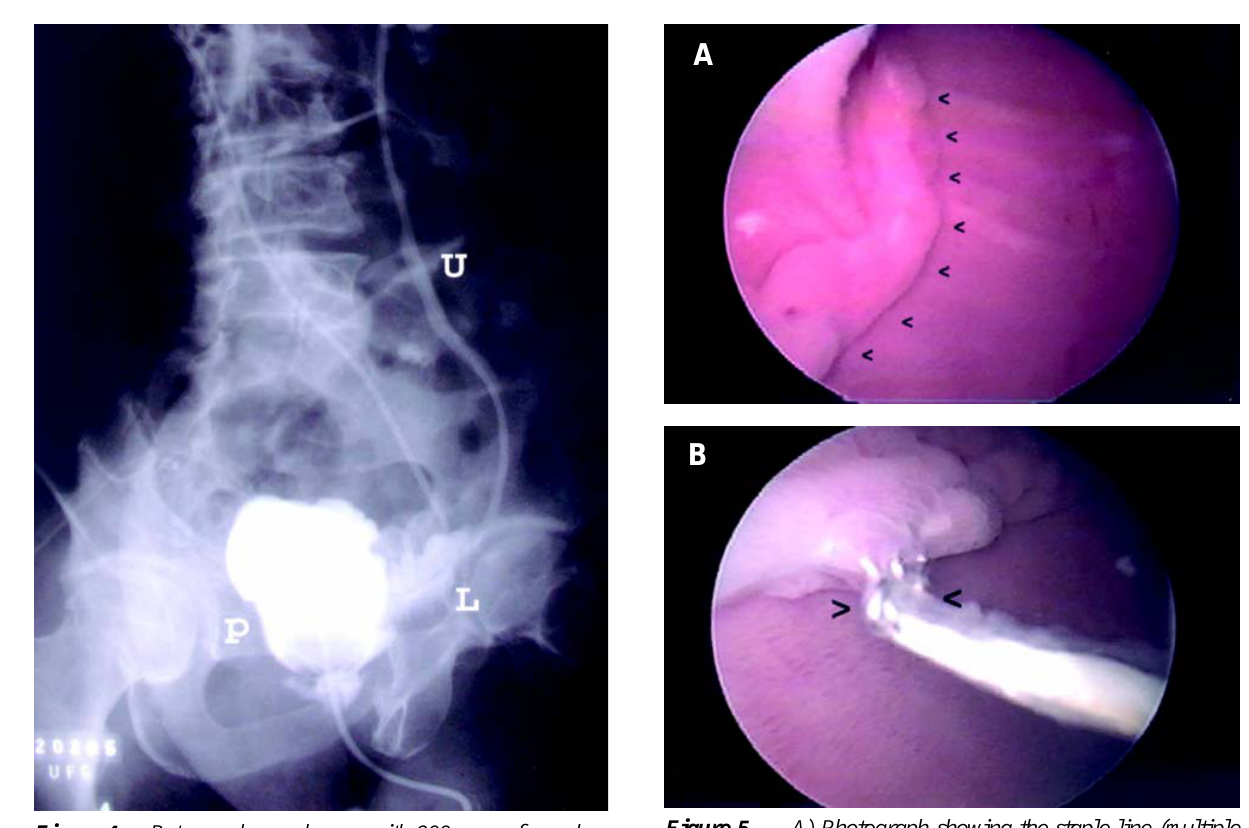
Figure 4 – Retrograde pouchgram with 200 cc performed on post-operative day 7 showing no signs of contrast extravasation, but free reflux of contrast from the limbs (L) of the pouch (P) to the ureters (U).